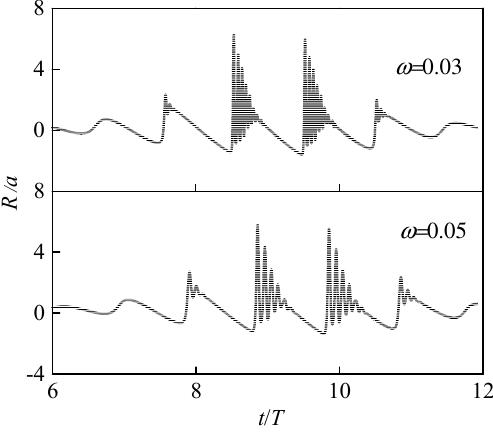
Figure 13. History of wave run-up along the vertical wall for multi-crest wave train cases of different wave frequencies.